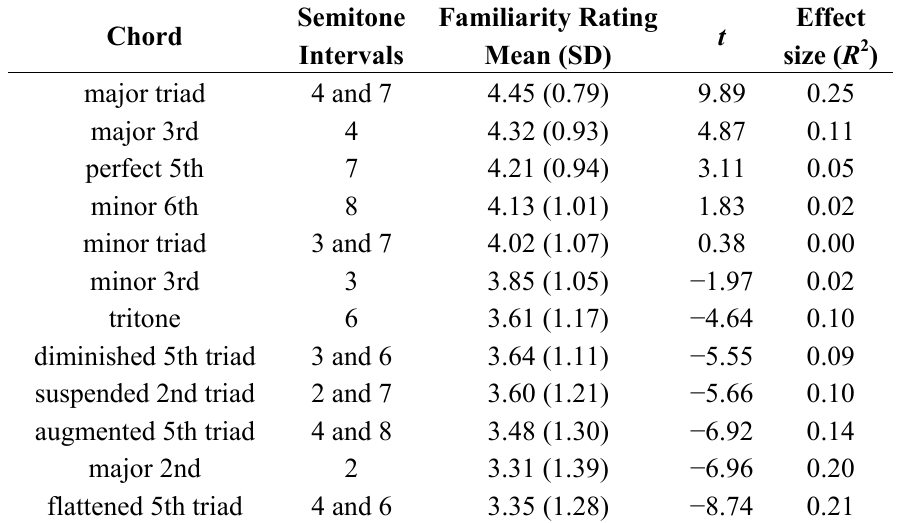
Table 3. Comparison of the mean familiarity ratings for each chord with the median rating score (4) across all participants by single sample t -tests. Items are listed in descending order of the t statistic, with values in bold indicating chords included in the high familiarity chord